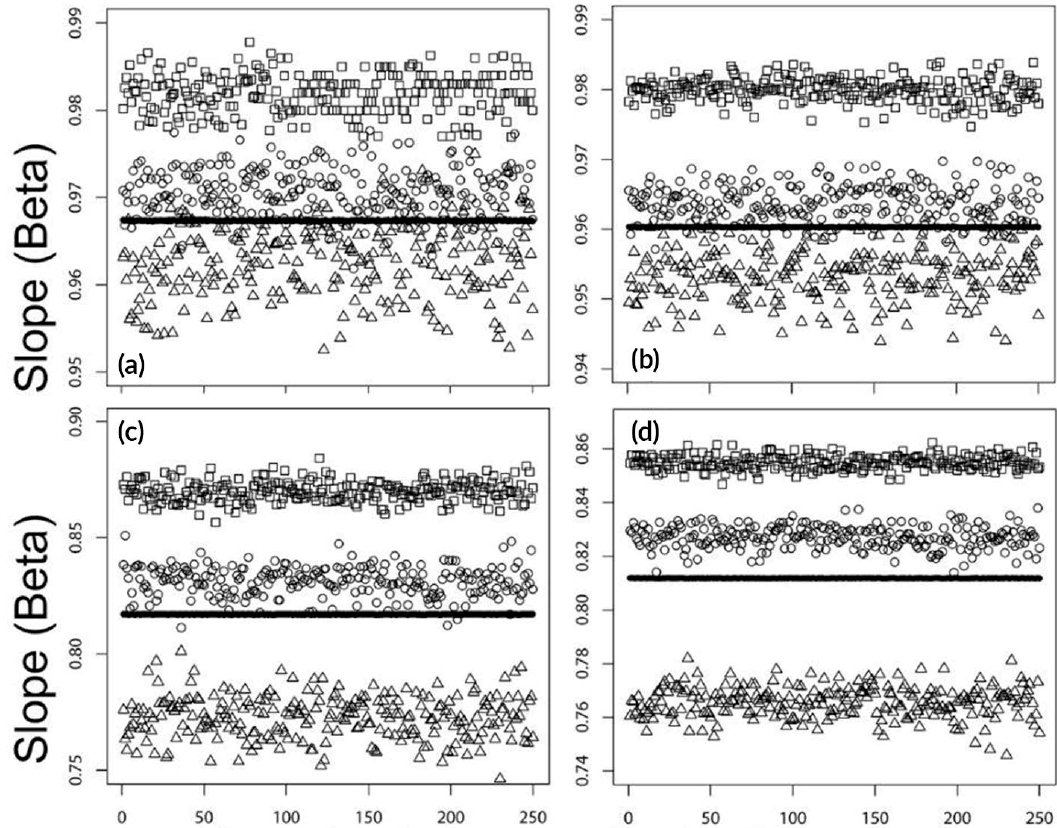
Figure 2. Estimated slopes (beta, true beta = 1.0) for four sets of simulation data (Sim1–Sim4) with 250 samples each. The panels illustrate the results for the following methods: ( a ) CC2D, ( b ) CC3D